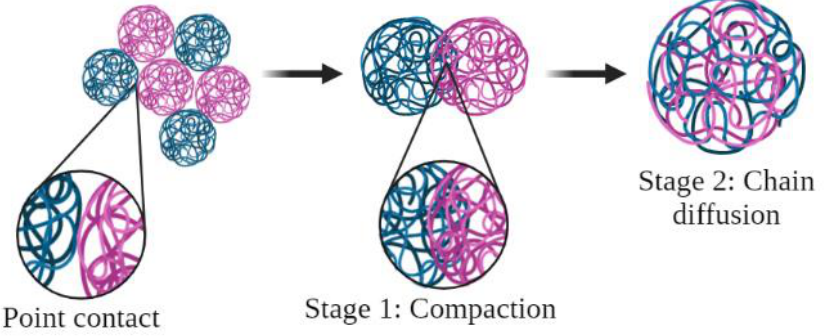
Figure 4. Schematic diagram of the two stages in press molding, adapted from [32].